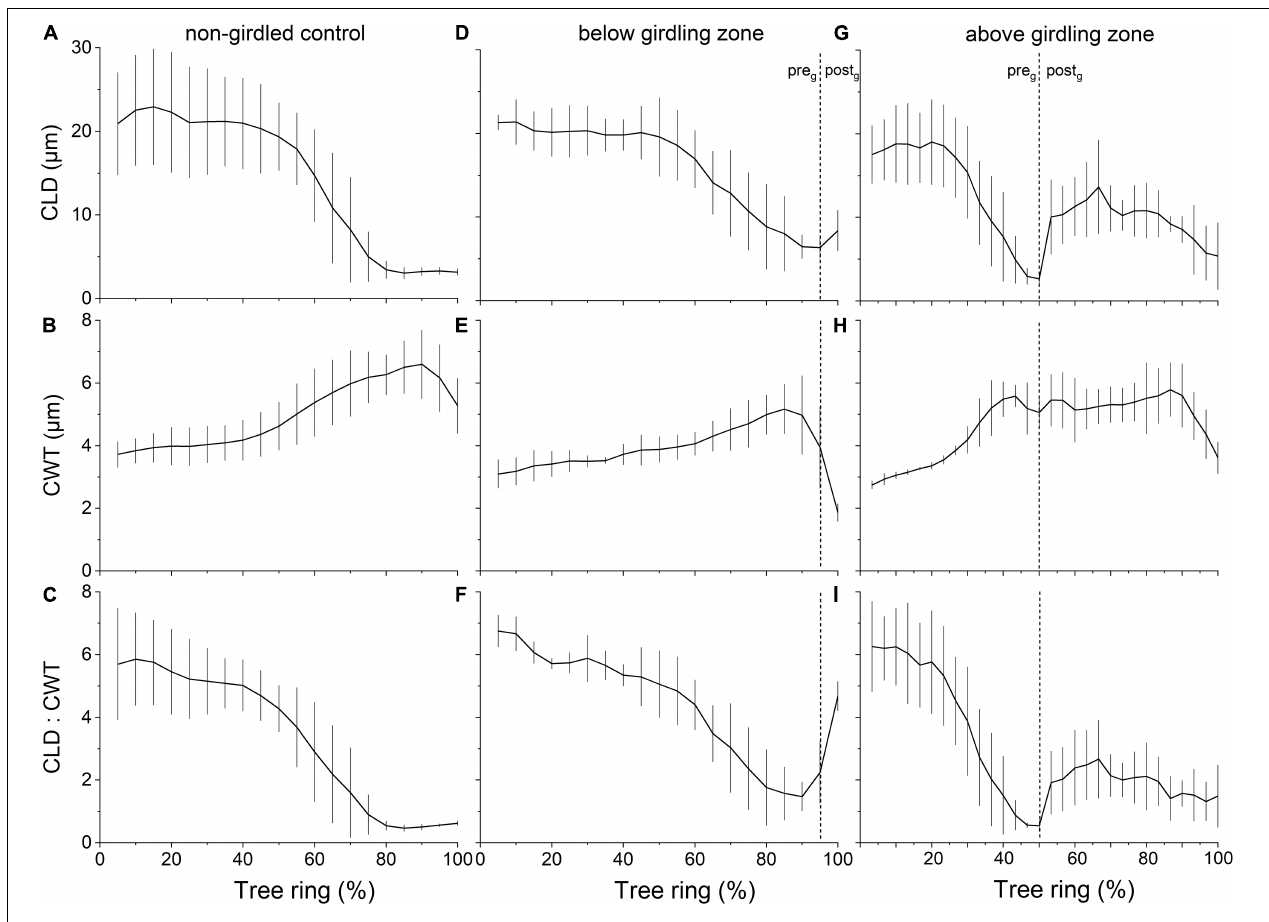
FIGURE 5 | Change in wood anatomical parameters throughout growing period(s) in (A–C) non-girdled controls ( n = 4) and (D–F) below and (G–I) above girdling ( n = 3). In (D–I) , the regular (i.e., pre-girdling = pre g ) and induced growing period (i.e., post-girdling = post g ) are separated by dotted lines. Data were normalized to overall cell count of the individual tree in 2019. Mean values ± standard deviations are